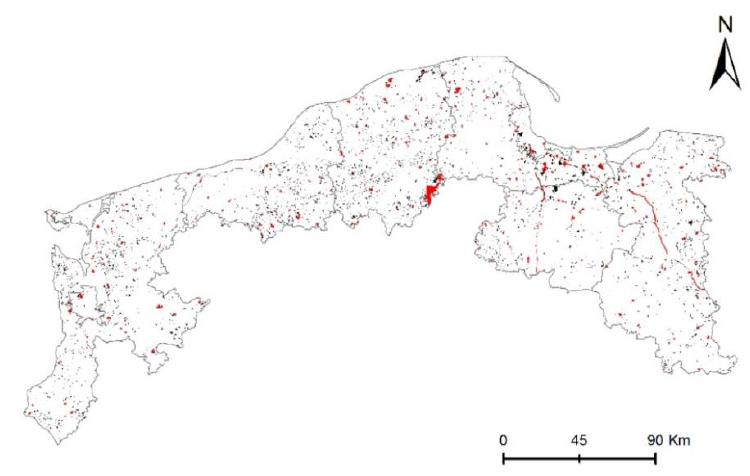
8 false colour composition; ( d ) High-resolution mosaic of Sentinel-2 (10 m) in true (bands 4,3,2) and false colour (bands 8,4,3) available by via Copernicus services (Elblag); ( e ) Geoportal services of region after the hurricane on August 11–12, 2017.